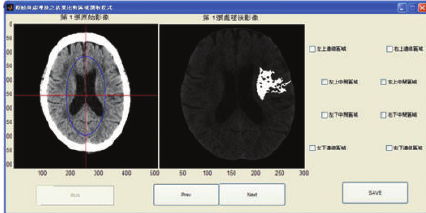
Figure 10: User interface for recording radiologists’ decision after seeing the image results of our proposed system (Test 2).